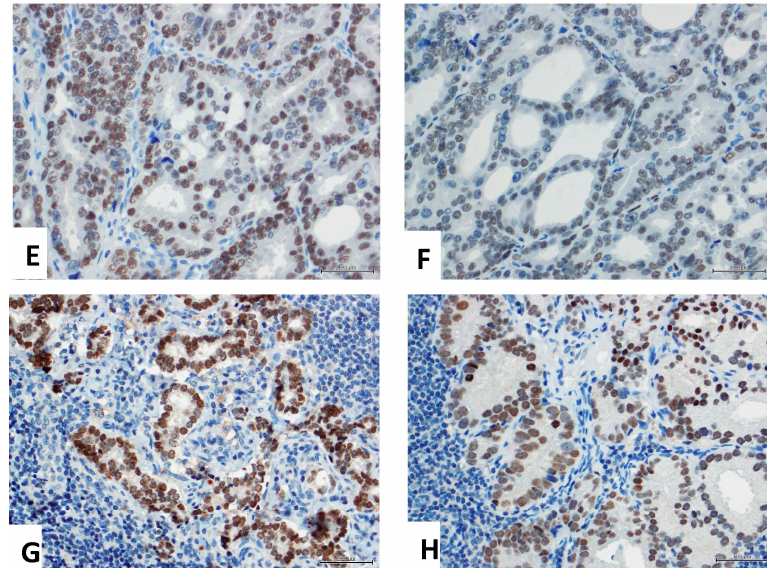
Figure 1. Immunohistochemistry of candidate diagnostic prostate markers. ( A ) Prostate specific antigen (PSA) shows diffuse cytoplasmic staining with a higher degree of heterogeneity in this case. ( B ) Prostein immunoreactivity is restricted to the Golgi apparatus area. ( C ) Prostate specific alkaline phosphatase (PSAP) also displays a diffuse cytoplasmic staining pattern. ( D ) Prostate specific membrane antigen (PSMA) has characteristic cytoplasmic but also membranous staining. ( E ) Androgen receptor shows epithelial nuclear staining. ( F ) ERG is also located in the nucleus and has a higher degree of heterogeneity, as seen here. ( G ) Homeobox gene NKX3.1 commonly displays strong nuclear staining. ( H ) Homeobox protein HOXB3 is also seen in nuclei, however, the staining intensity is weaker. All images are taken in 400×.